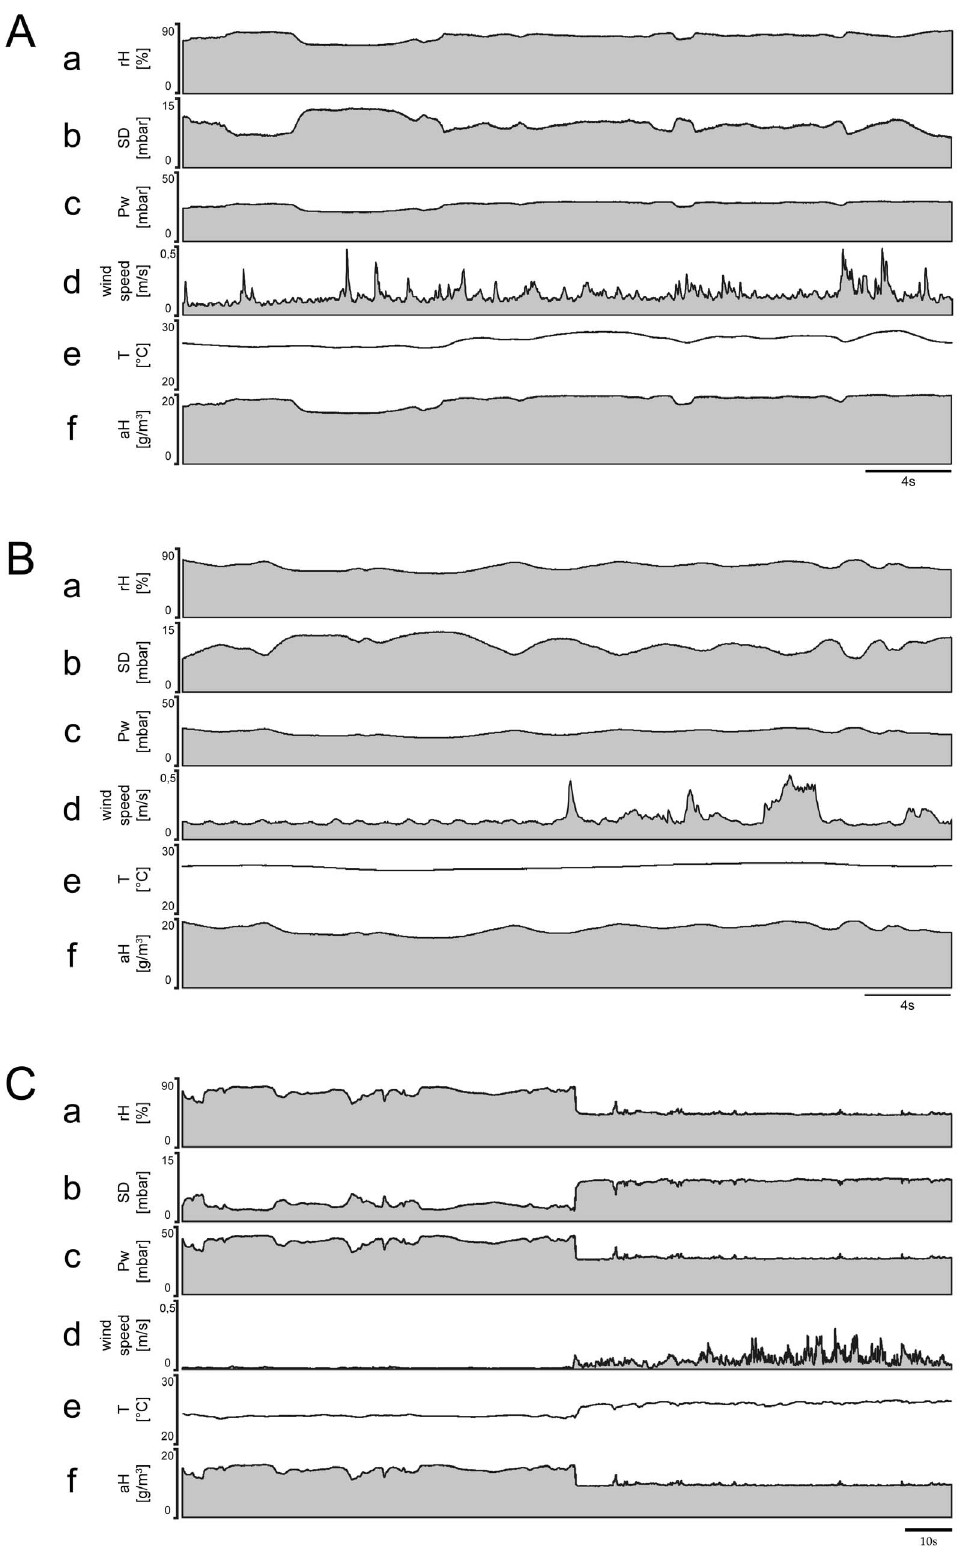
Figure 8. Temporal profiles of absolute humidity, temperature and wind speed recorded while traveling through different habitats. A. Open grassy field. B. Deciduous forest. C. Edge habitat characterized by overhanging canopy and grassland. In each habitat, temporal profiles of relative humidity ( a ), saturation deficit ( b ) and water vapor pressure ( c ) were determined from the measured values of absolute humidity ( f ) and air temperature ( e ). Peak wind speeds ( d ) were not reflected in the profiles of relative humidity ( a ), saturation deficit ( b ) and water vapor pressure. aH absolute humidity, Pw water vapor pressure, rH relative humidity, SD saturation deficit, T temperature. doi:10.1371/journal.pone.0099032.g008 PLOS ONE |